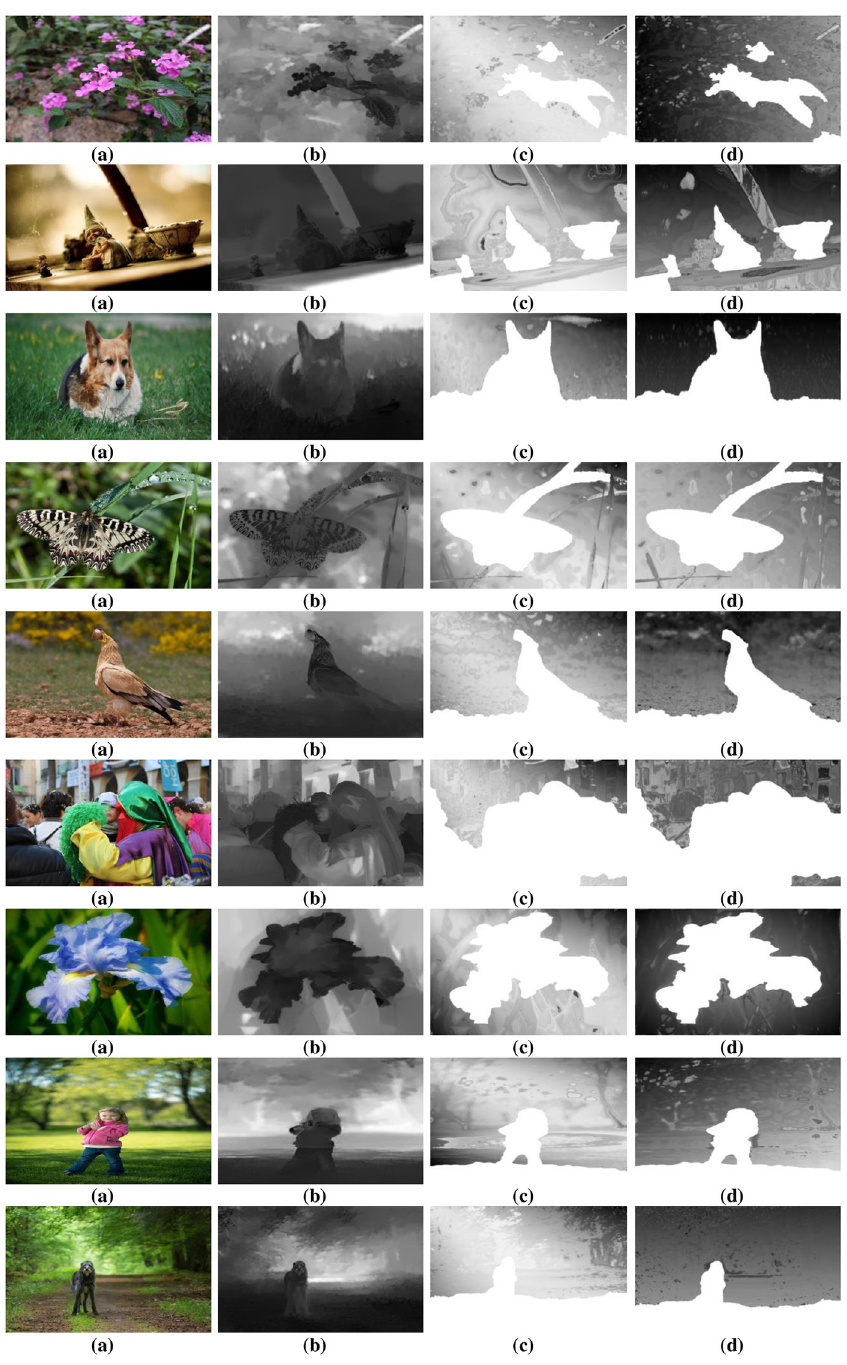
Fig 13. Depth map results of dataset [38]. ( a ) Input Images ( b ) Depthmap produced by Zhuo.et al. [12] ( c ) Depthmap produced by Yang.et.al. [26] and ( d ) Depth-map generated by DFB-DIBR.